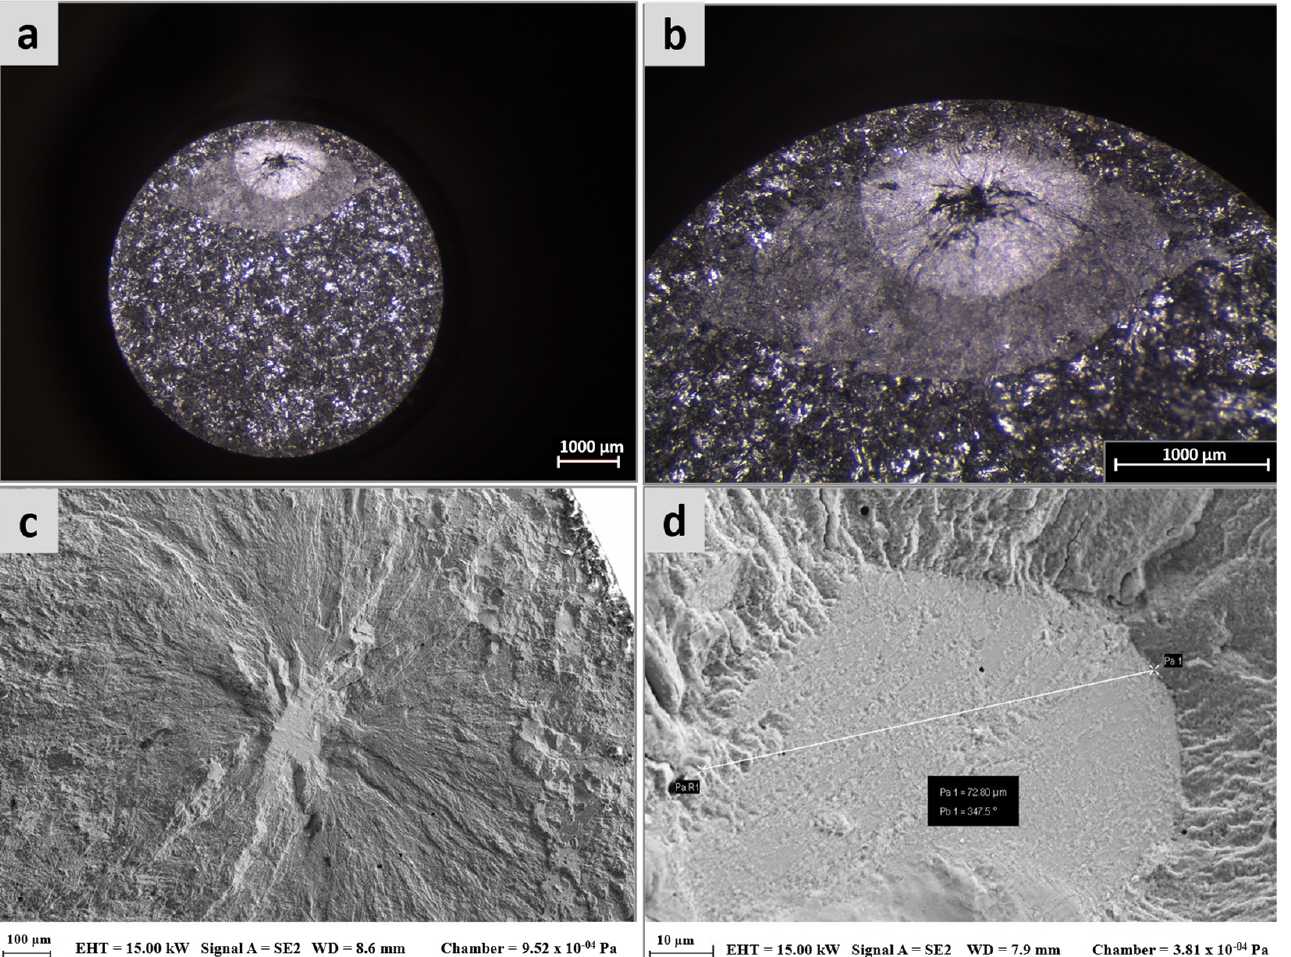
Figure 11. ( a ) example of the final fracture surface of the nitrided material specimen; 10× stereoscopic image. ( b ) Example of subsurface fatigue propagation of nitrided material specimen; note fish-eye nucleation with ODA; 25× stereoscopic image. ( c ) Fish-eye nucleation example. ( d ) Matrix failure detail.